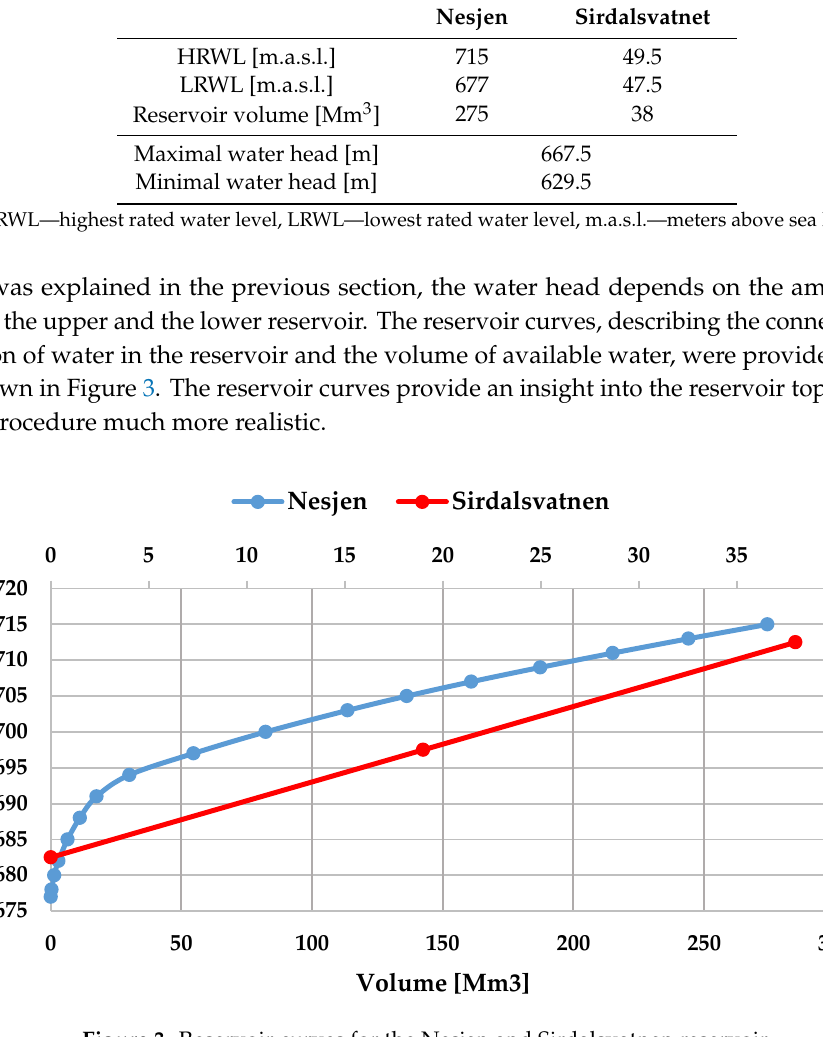
Figure 3. Reservoir curves for the Nesjen and Sirdalsvatnen reservoir.